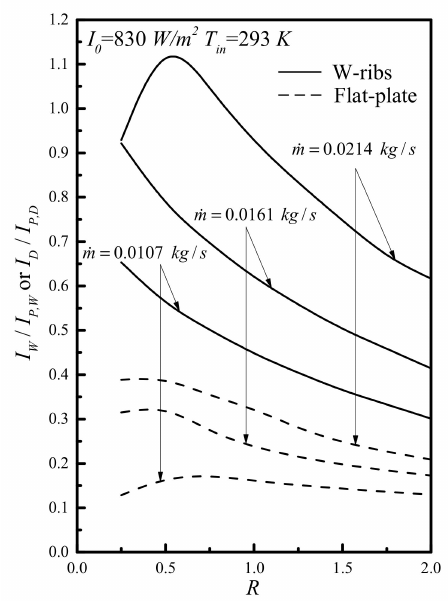
Figure 10. The ratio of I W / I P , W vs. recycle ratio R for